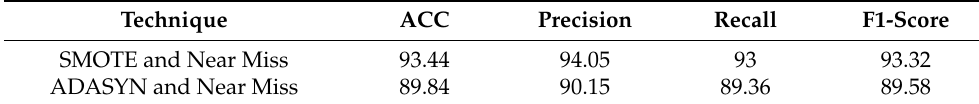
Table 14. Evaluation metrics for the CICIDS2017 dataset with hybrid